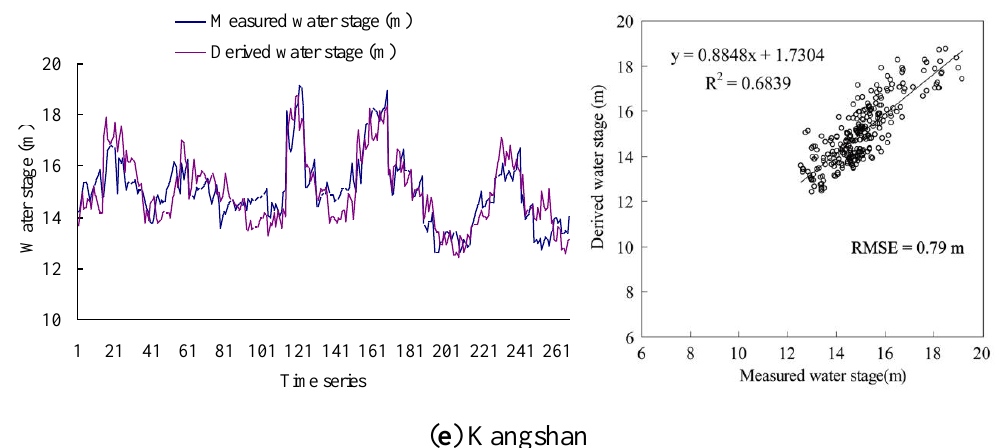
Figure 3. Comparison of derived water level and gauge-observed values at ( a ) Hukou station, ( b ) Xingzi station, ( c ) Duchang station, ( d ) Tangyin station, and ( e ) Kangshan station. The number of measurements N is 268.